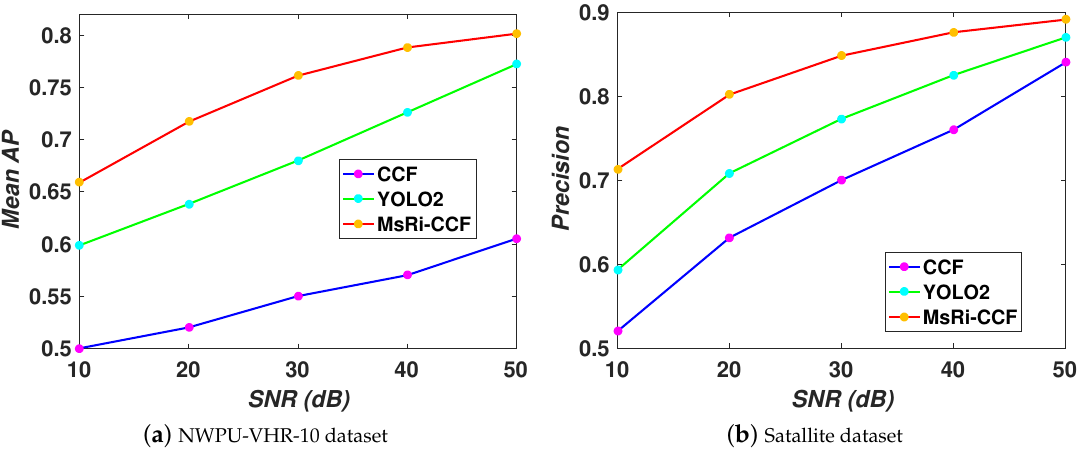
Figure 8. Evaluation of robustness to noise of the MsRi-CCF framework.